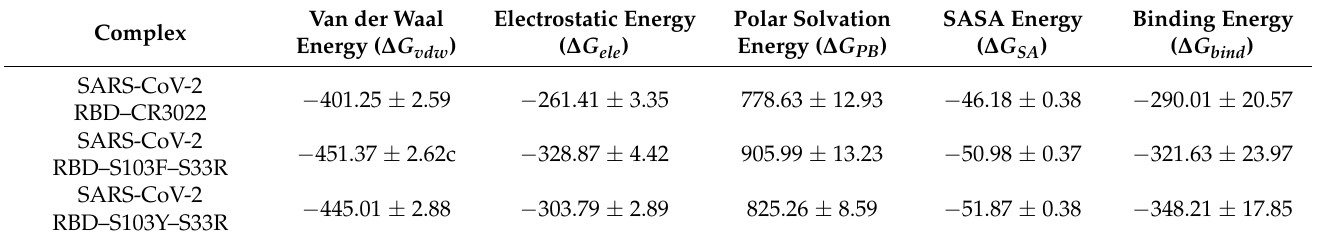
Table 3. The binding free energy of the SARS-CoV-2 RBD with the wild-type CR3022 antibody, S103F–S33R and S103Y–S33R